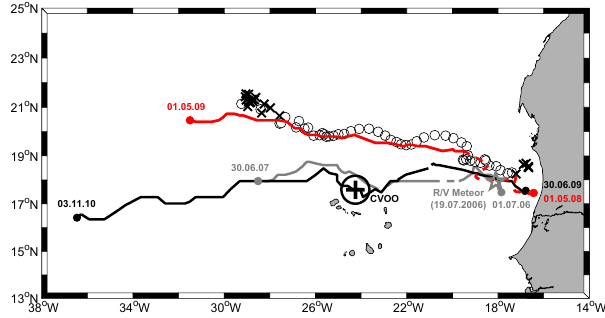
Figure 1. Overview map of the eastern tropical North Atlantic oxy- gen minimum zone. The tracks of the two anticyclonic-modewater eddies (CVOO2007, grey line; CVOO2010, black line) observed at CVOO (plus sign; 17 ◦ 35.39 (cid:48) N, 24 ◦ 15.12 (cid:48) W) as well as the track of the cyclonic eddy (Argo2008, red line), surveyed with an Argo float are shown. The position (dots) and dates (label) of the first and last identification of the three eddies are given. The RV ME- TEOR survey of the CVOO2007 (grey star) is labelled accordingly. For reference, the average footprint (circle at CVOO) is given. Po- sitions of the Argo float profiles surveyed inside (white circles) as well as outside the cyclonic eddy radius (crosses) are